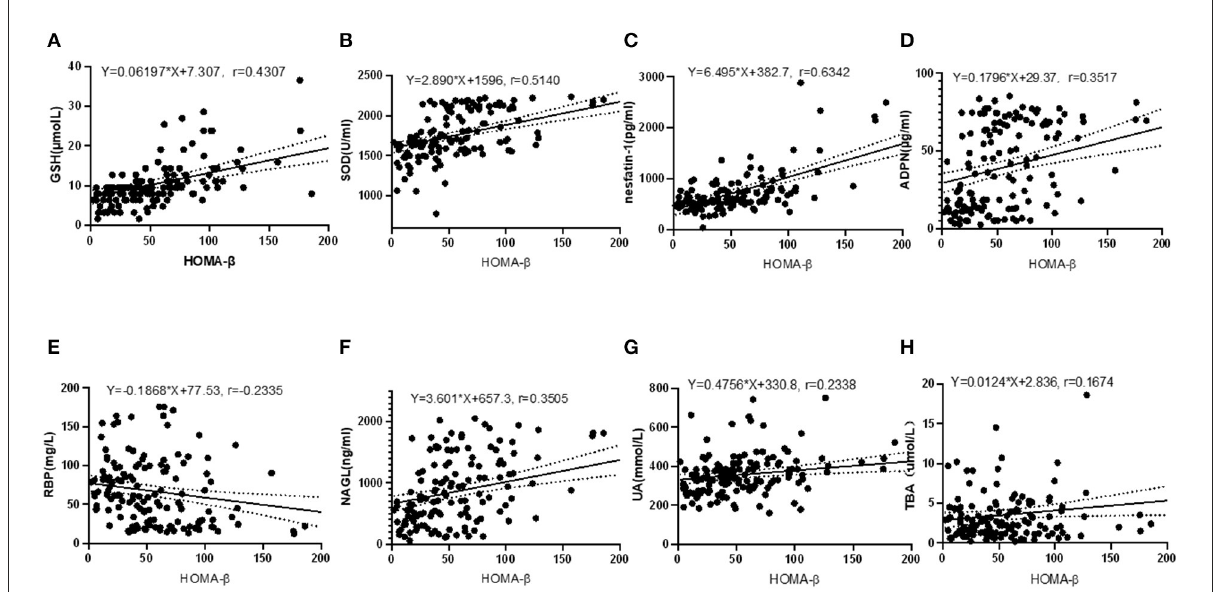
FIGURE2 Correlations between HOMA- β and GSH, SOD, nesfatin-1, ADPN, RBP, NAGL, UA and TBA. (A) correlation between HOMA- β and GSH ( R 2 = 0.1855, F = 31.88, P < 0.001); (B) correlation between HOMA- β and SOD ( R 2 = 0.2642, F = 50.26, P < 0.001); (C) correlation between HOMA- β and nesfatin-1( R 2 = 0.4022, F = 94.18, P < 0.001); (D) correlation between HOMA- β and ADPN ( R 2 = 0.1237, F = 19.77, P < 0.001); (E) correlation between HOMA- β and RBP ( R 2 = 0.0545, F = 8.070, P = 0.005); (F) correlation between HOMA- β and NAGL ( R 2 = 0.1299, F = 19.61, P < 0.001); (G) correlation between HOMA- β and UA ( R 2 = 0.0547, F = 8.097, P = 0.005); (H) correlation between HOMA- β and TBA ( R 2 = 0.0280, F = 4.034, P = 0.046).